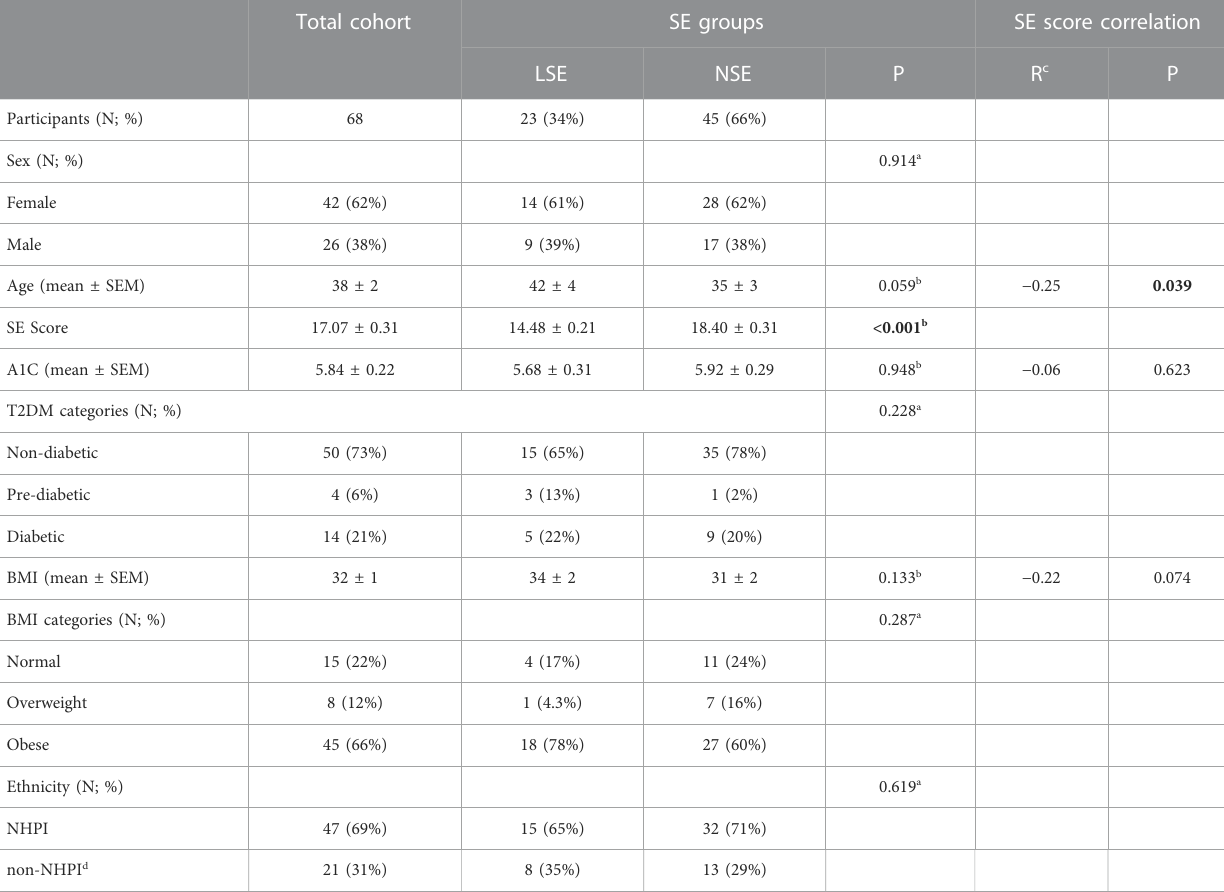
TABLE 1 Sociodemographic and biometric summary of our NHPI-enriched cohort strati fi ed by self-esteem score. Biometric summary of our cohort displaying comparative and correlational analyses with respect to self-esteem